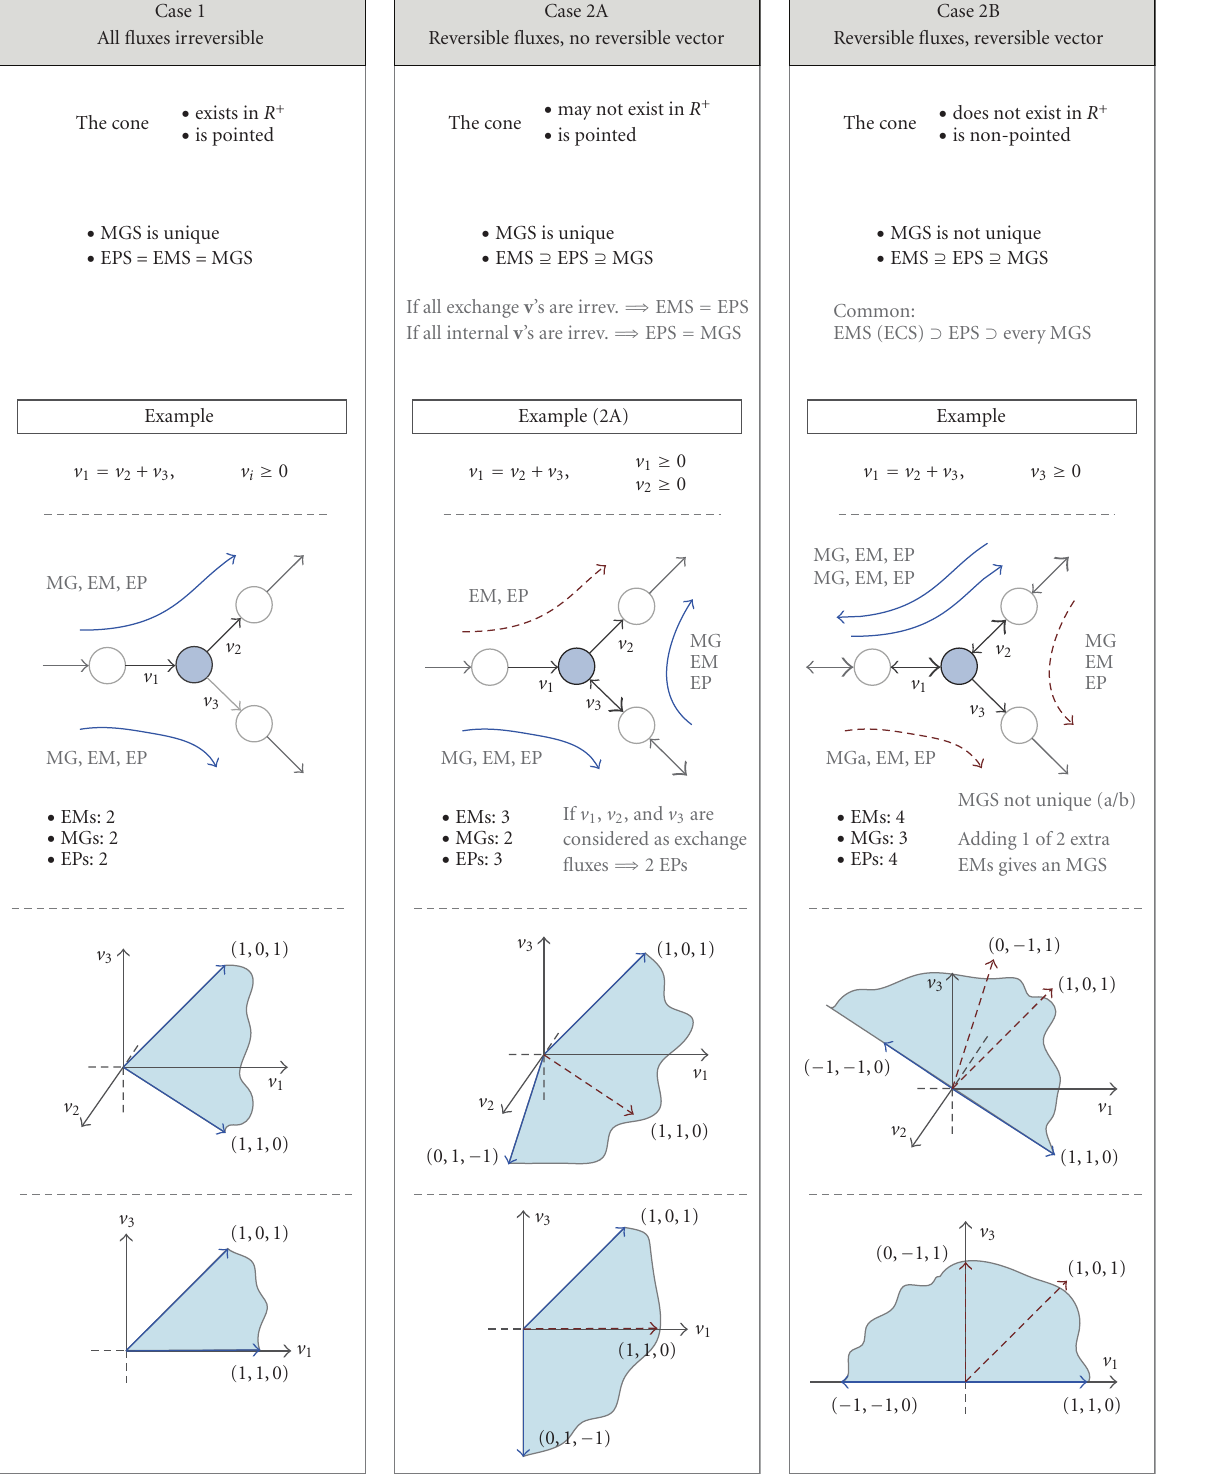
Figure 2: Case-based scheme of the di ff erent network-based pathways. In each example metabolites are represented with circles connected with thin arrows that represent the fluxes. The reversible fluxes are double arrowed (solid arrowhead defines the sign criteria). The blue thick arrows denote generating vectors that correspond to extreme rays of the cone and the red ones to the rest of generating vectors. The axis at the bottom depicts the flux-space over { v 1 , v 2 , v 3 } , blue area, and its generating